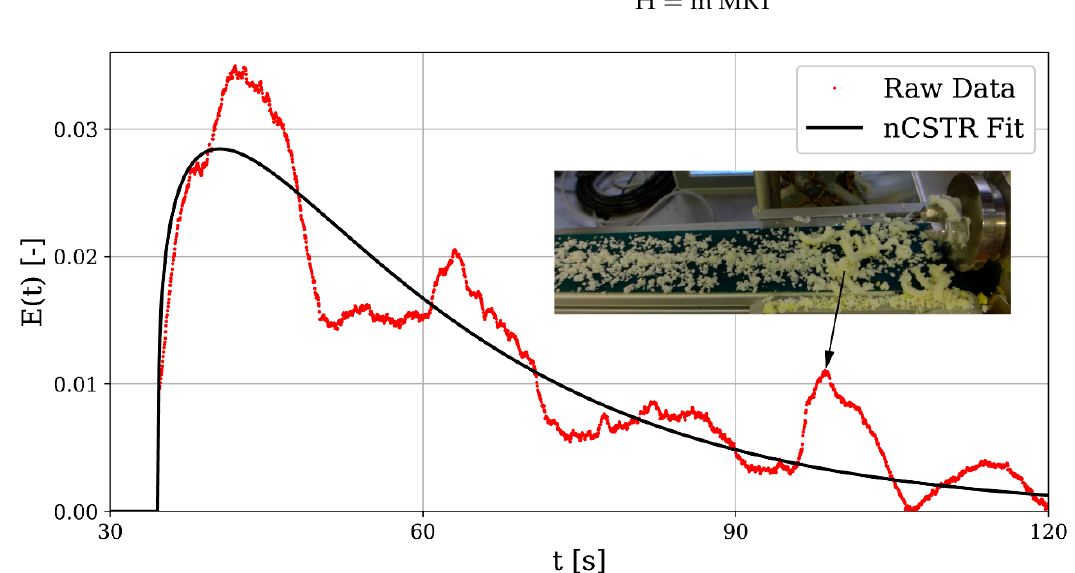
Figure 8. Residence time distribution E(t) for experiment N21, showing eventual mass flow pulsations. Inset shows video snapshot, taken at the time of the second peak.